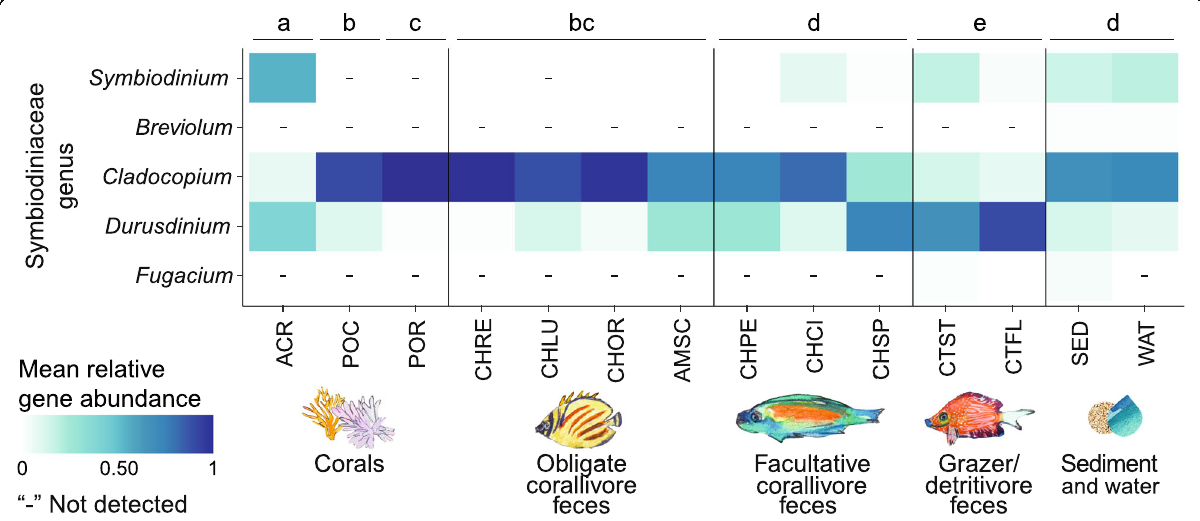
Fig. 3 The communities of Symbiodiniaceae in obligate corallivore (coral-eating animal) feces are most similar to the communities of Symbiodiniaceae in two locally abundant coral species. Mean relative abundance of hits to a given Symbiodiniaceae genus in corals, obligate corallivore feces, facultative corallivore feces, grazer/detritivore feces, and reef-associated sediment and water (all included samples had >1000 reads). Mean relative abundances were calculated across all samples from a species or sample category. Dashes ( “ - ” ) indicate that a Symbiodiniaceae genus was not detected in any of the samples from a fish species or sample category. Squares appearing white but without a “ - “ had low ( ≤ 1%) but still detectable mean relative abundances. Different letters indicate significant differences in Symbiodiniaceae community compositions based on pairwise PERM ANOVA tests ( p <0.05, using the Benjamini-Hochberg correction for multiple comparisons) using Bray-Curtis distances based on randomly subsampled ( n =12) untransformed data (Table S1, S4). Overall PERMANOVA test results: df=6, F=17.30, R 2 =0.58, p =0.001. Species and sample categories (and the fraction of samples that had >1000 reads and were thus included in the analysis) are as follows: Corals: Acropora hyacinthus , Acropora (11/12); Pocillopora species complex, Pocillopora (12/12); Porites lobata species complex, Porites (12/12). Obligate corallivores: Chaetodon reticulatus, CHRE (11/11); Chaetodon lunulatus, CHLU (8/8); Chaetodon ornatissimus, CHOR (14/14); Amanses scopas, AMSC (7/7). Facultative corallivores: Chaetodon pelewensis, CHPE (8/8); Chaetodon citrinellus, CHCI (6/6); and Chlorurus spilurus CHSP (8/8). Grazer/Detritivores: Ctenochaetus striatus, CTST (6/6); and Ctenochaetus flavicauda, CTFL (7/8). Sediment and water: Sediment, SED (12/12); Water, WAT (7/12). For data used, see Additional file